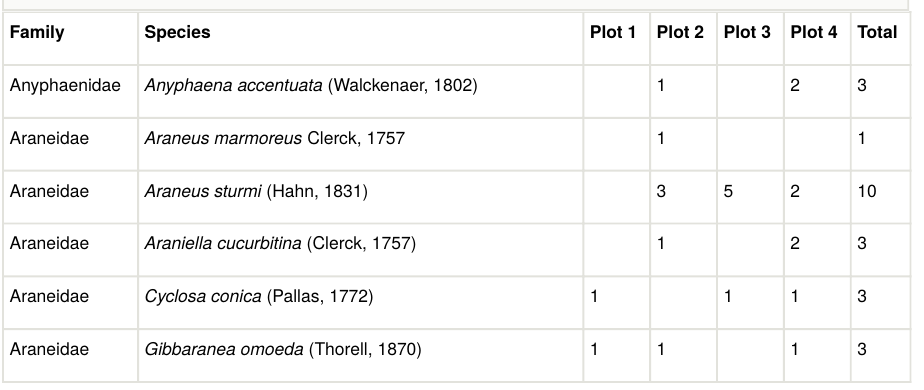
Richness and abundance of species per plot (adults